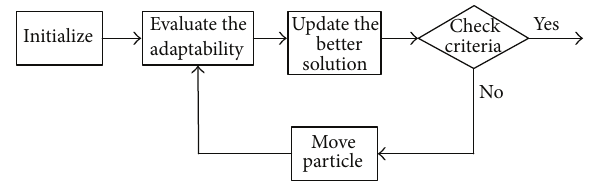
Figure 5: Flow chart of PSO search